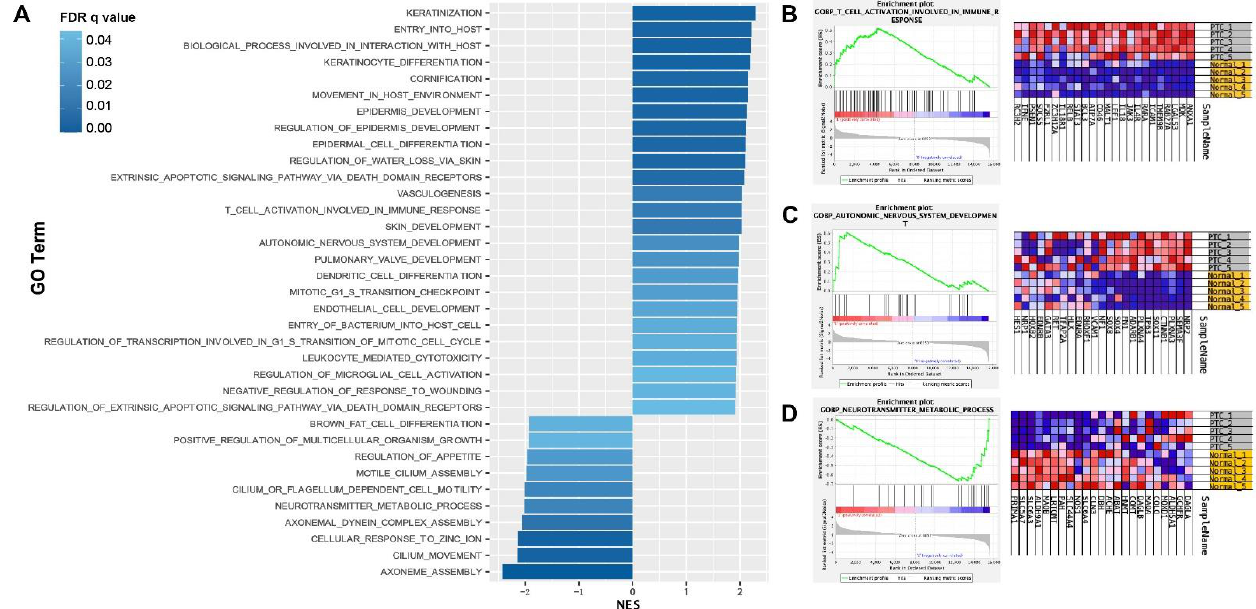
Figure 3. GSEA. ( A ) GO terms enriched by PTC tissues (NES > 0) or adjacent normal tissues (NES < 0). ( B – D ) Representative enrichment plots and heatmap of genes involved in selected GO terms.